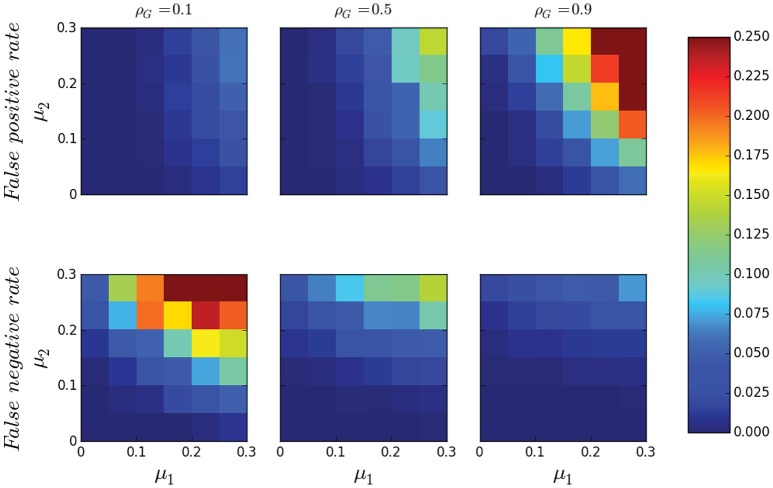
False positive rate and false negative rate of MANIA as a function of μ1 and μ2 for sparse networks (ρG = 0.1), medium density networks (ρG = 0.5) and dense networks (ρG = 0.9). Each square is the average of 1000 independent simulations.